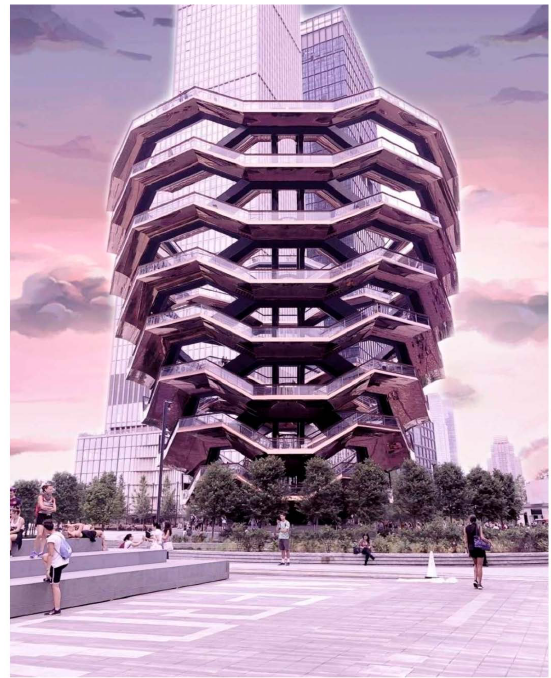
Figure 1. Vessel (Photo credit: Yunyu Xiao).